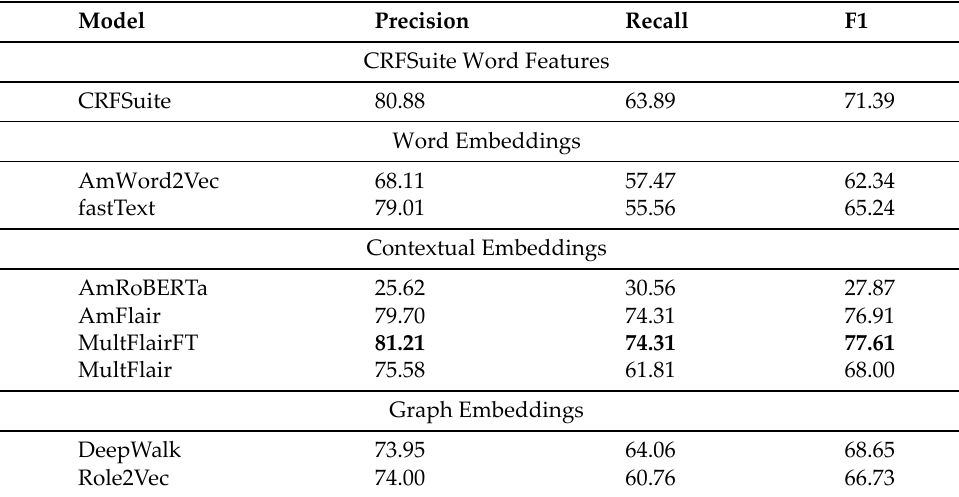
Table 7. Experimental results for NER classification